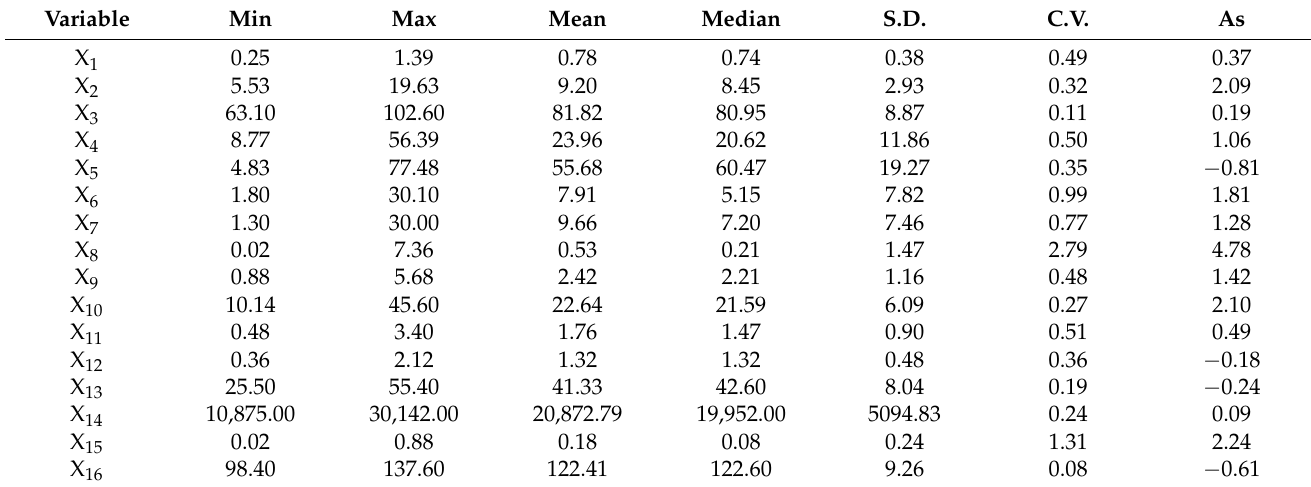
Table 3. Descriptive statistics of the variables used in the study.